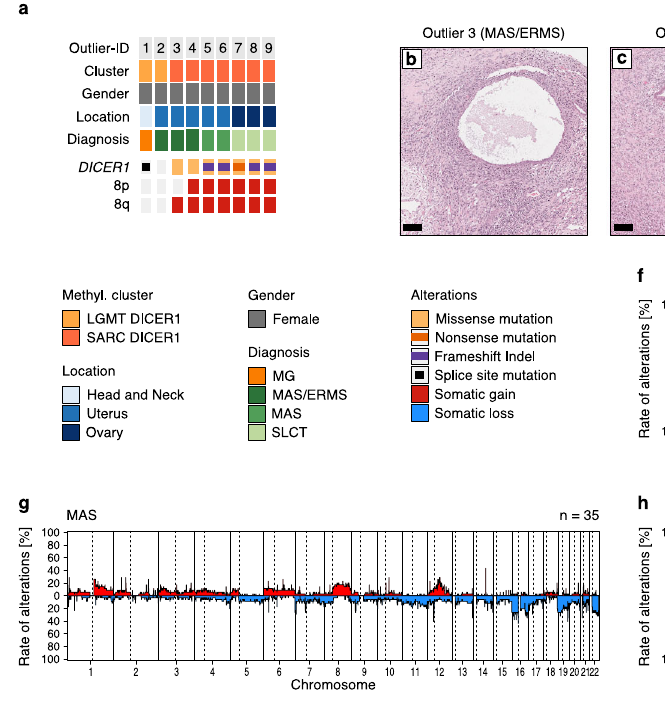
Fig. 5 | Characteristics of DNA methylation outlier in clusters of mesenchymal neoplasms with DICER1 alteration. a DICER1 variants and chromosome 8 copy number status of 9 thyroid, uterine and ovarian tumors, that clustered with LGMT DICER1orSARCDICER1inDNAmethylationanalysis(Fig.1a).AboveoutlierID,DNA methylation class assignment, gender, tumor location and institutional diagnoses are annotated as indicated by the fi gure ’ s legend. b – e Limited histomorphological